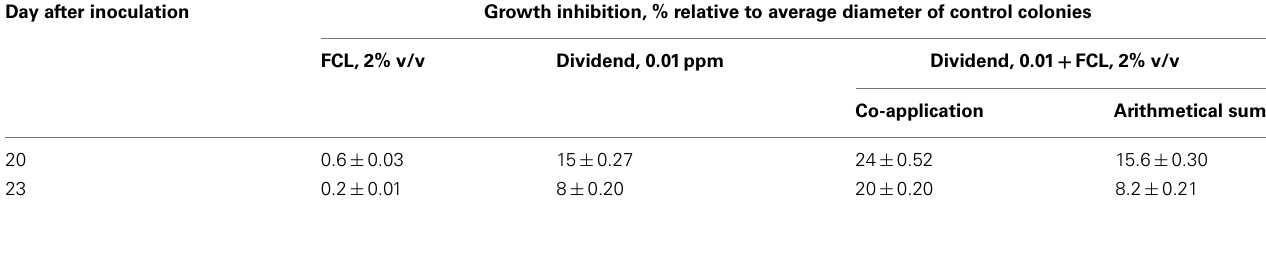
Table 3 | Enhancement of antifungal activity in vitro toward the growth of S. nodorum after co-application of Dividend and filtrate of cultural liquid (FCL) produced by a biocontrol isolate of F. sambucinum , FS-94. Day after